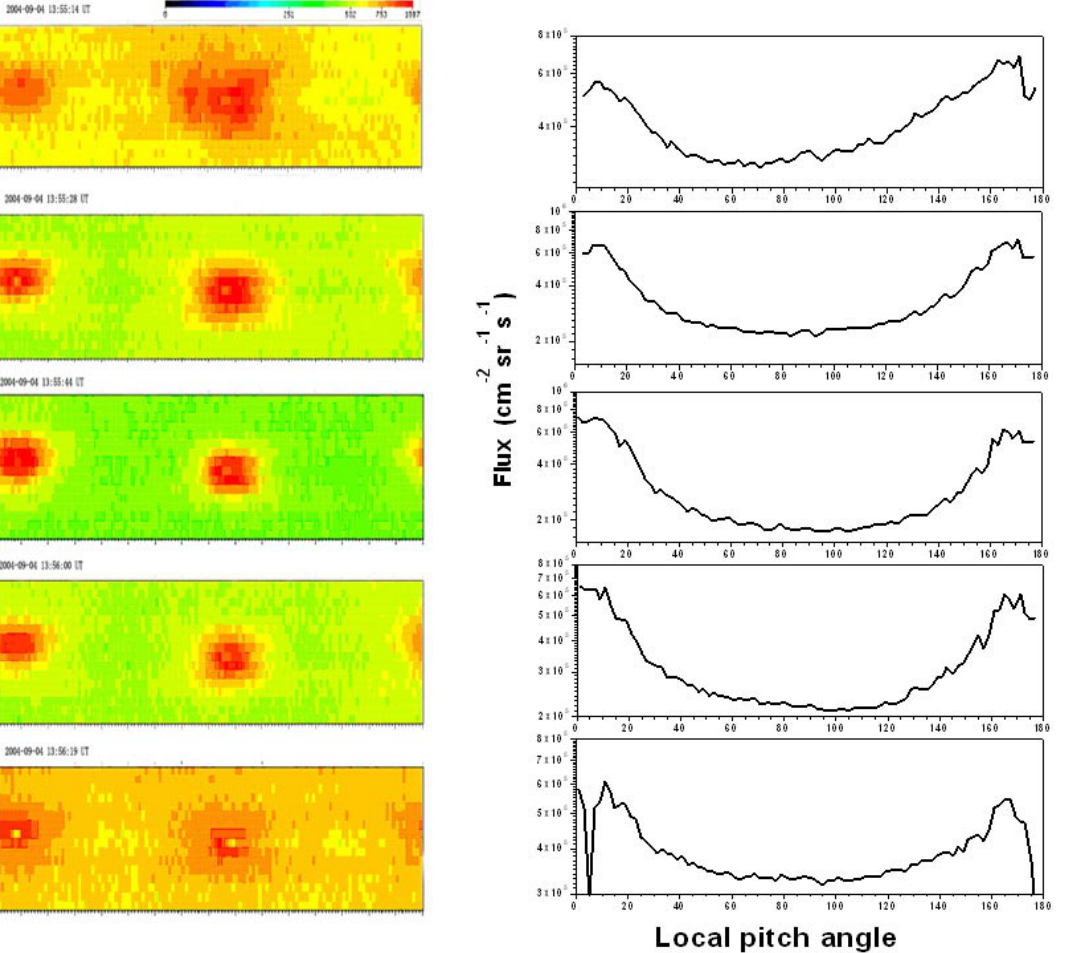
Fig. 6. NUADU data frames (left side) and local PAD plots (right side) for the interval 13:55:14 UT to 13:56:19 UT on 4 September 2004. The data show, from top to bottom, the evolution of dumbbell-type PADs, where each abscissa (left side) covers 128 azimuths, with 2.8125 ◦ to each pixel, and each ordinate (left side) covers 16 elevations, with 11.25 ◦ to each pixel. The colour scales on the top illustrate the particle counts in each pixel. The flux peaks in each local PAD plot (right panels) correspond to the red areas in the frames on the left.